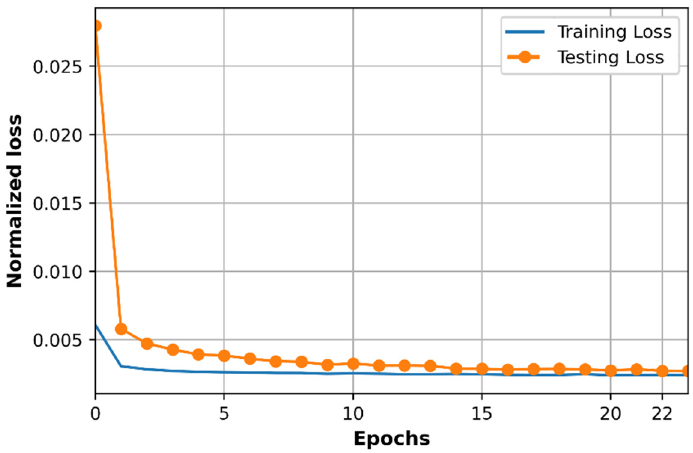
Figure 8. Loss of training and testing datasets according to epochs.